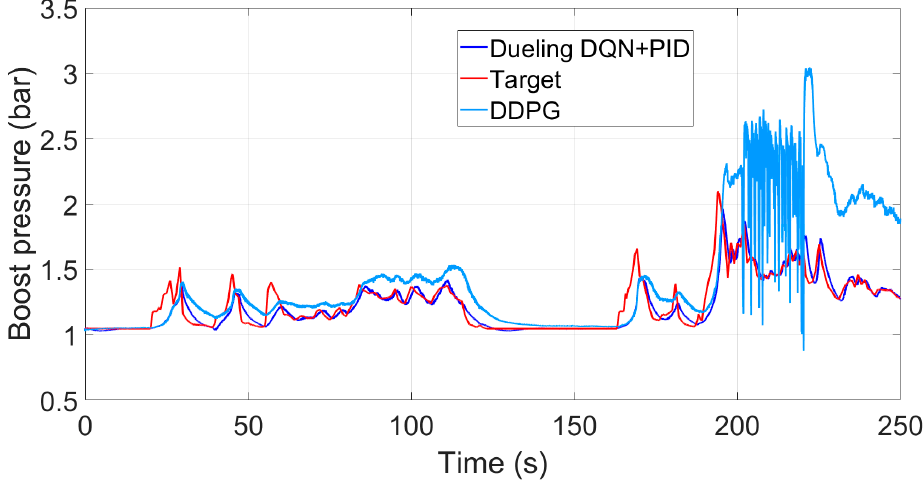
Figure 10. Control behavior comparison between the DDPG and the proposed hybrid algorithm at the very first training episode.